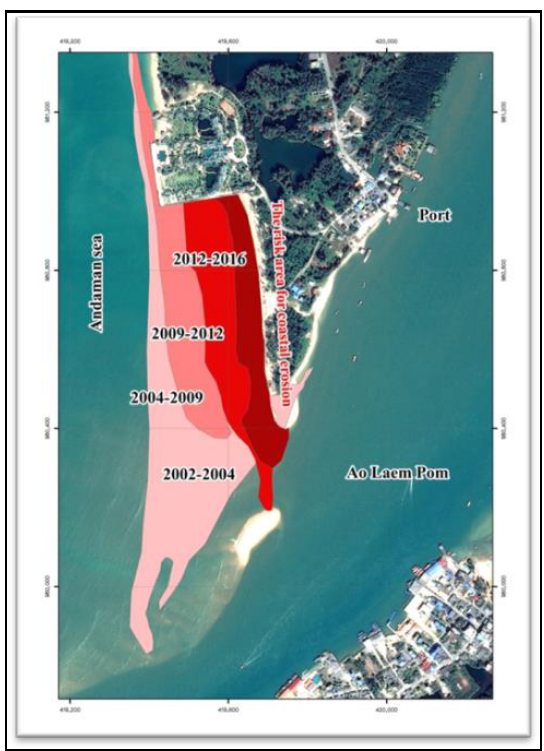
Figure 5. The severe erosion of Koh Kho Khao and the special monitoring